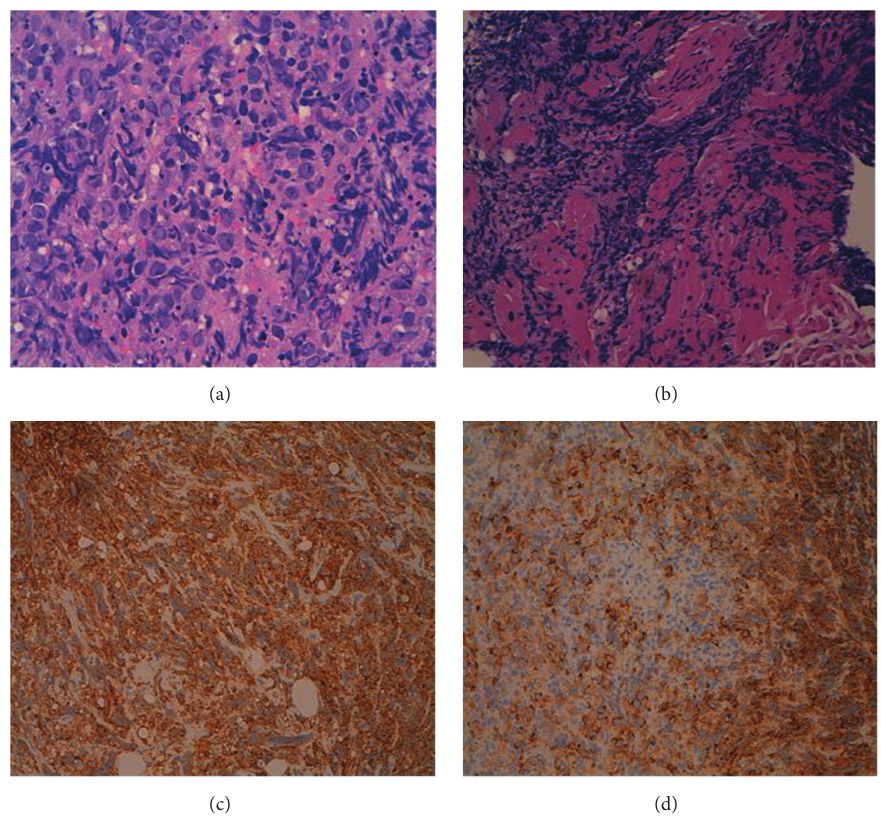
Figure 3: Histological findings. ((a) and (b)) The endomyocardial biopsy showed blastic infiltrate associated with myocardial necrosis (hematoxylin and eosin stain). ((c) and (d)) Infiltrating cells were strongly positive for CD45 (c) and CD34